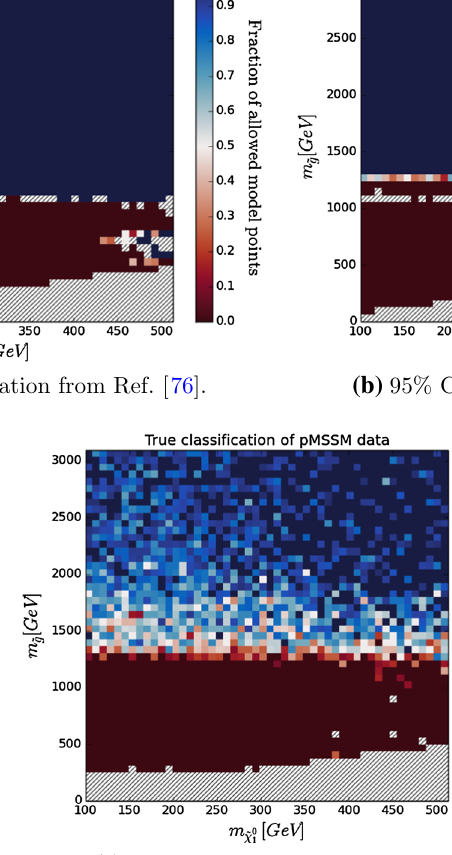
Fig. 8 ResultsoftestinganaturalSUSYscenariowiththetrainedclas- sifier in the higgsino LSP and gluino mass plane assuming stop masses larger than 600 GeV. The colors indicate the probability that a partic- ular point is not excluded. For reference c shows the training data in